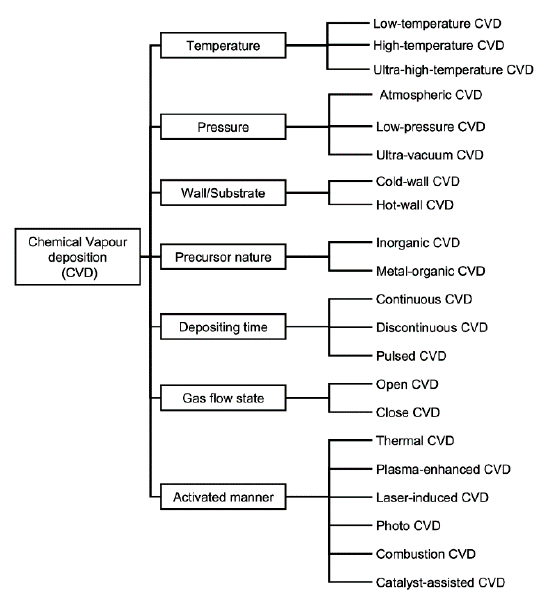
Figure 1. Classification of CVD methods (reprinted with permission from [23]).